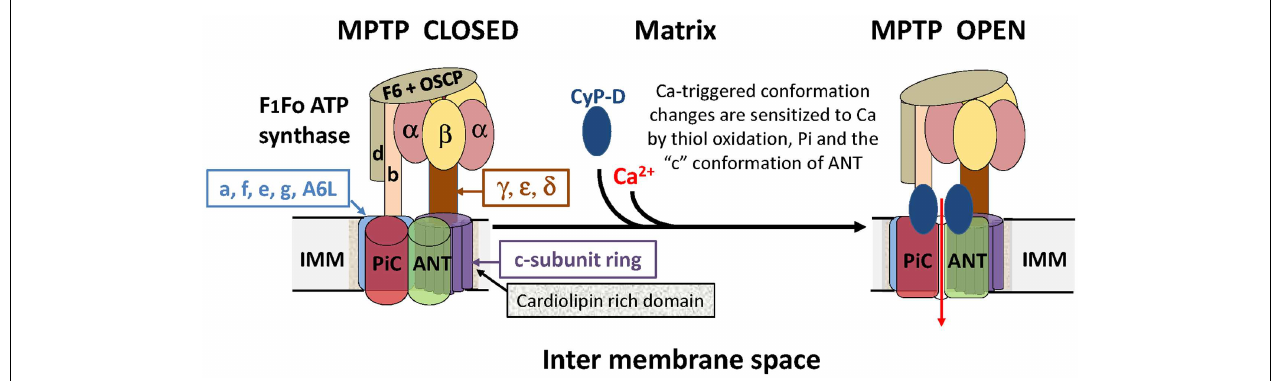
FIGURE 1 |A hypothetical model of the MPTP that proposes an interaction between theANT, PiC, and F1FoATP synthase in theATP synthasome . It is proposed that the MPTP forms at the interface between interacting domains of the PiC, ANT, and Fo ATP synthase following calcium triggered conformational changes facilitated by the PPIase activity of CyP-D. Note that potential regulatory interactions of the MPTP with outer membrane components are not